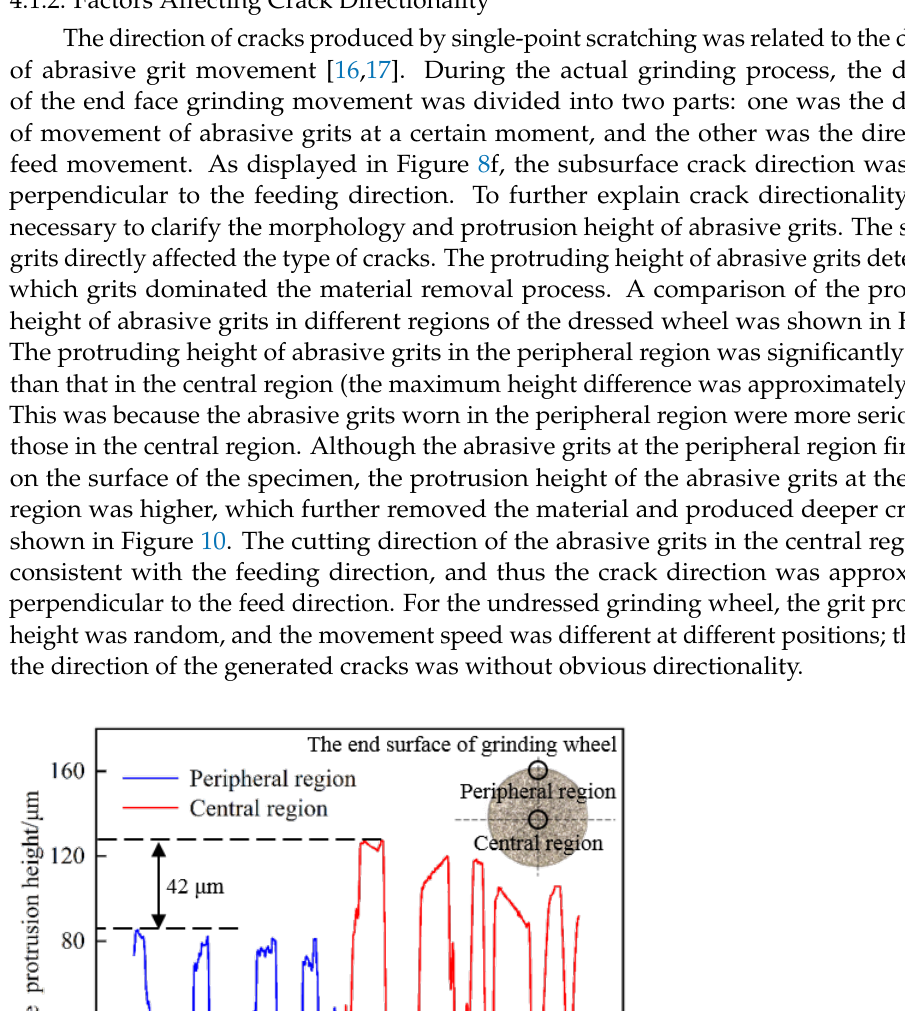
Figure 8. Distribution characteristics of cracks at different subsurface depths under the action of the dressed wheel: subsurface depth ( a ) 0 μm, ( b ) 42.5 μm, ( c ) 65.7 μm, ( d ) 82.9 μm, ( e ) 89.6 μm, and ( f ) 96.7 μm. The red circles in the figure show the variations in a bifurcation crack with subsurface depth.